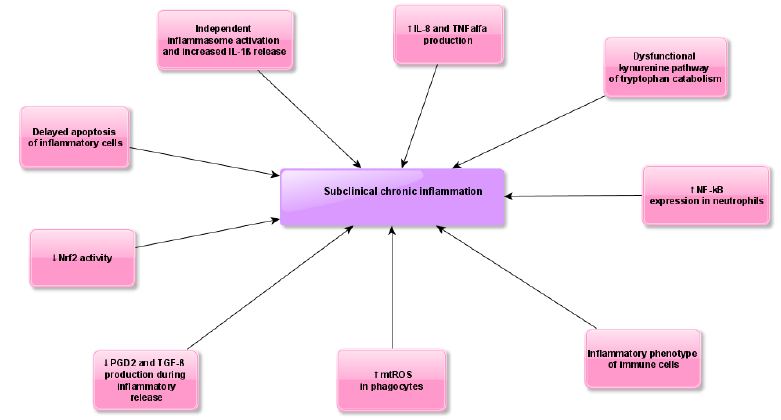
Figure 1. Possible mechanisms of dysregulated inflammatory response during chronic granulomatous disease (CGD). Abbreviations: IL-8, Interleukin–8; IL-1 β , Interleukin–1 β ; Nrf2, nuclear factor erythroid 2-related factor 2; PGD2, prostaglandin D2; TGF- β , transforming growth factor beta; mtROS, mitochondrial reactive oxygen species; NF- κ B, nuclear factor kappa-light-chain-enhancer of activated B cells; TNF alfa, tumor necrosis factor